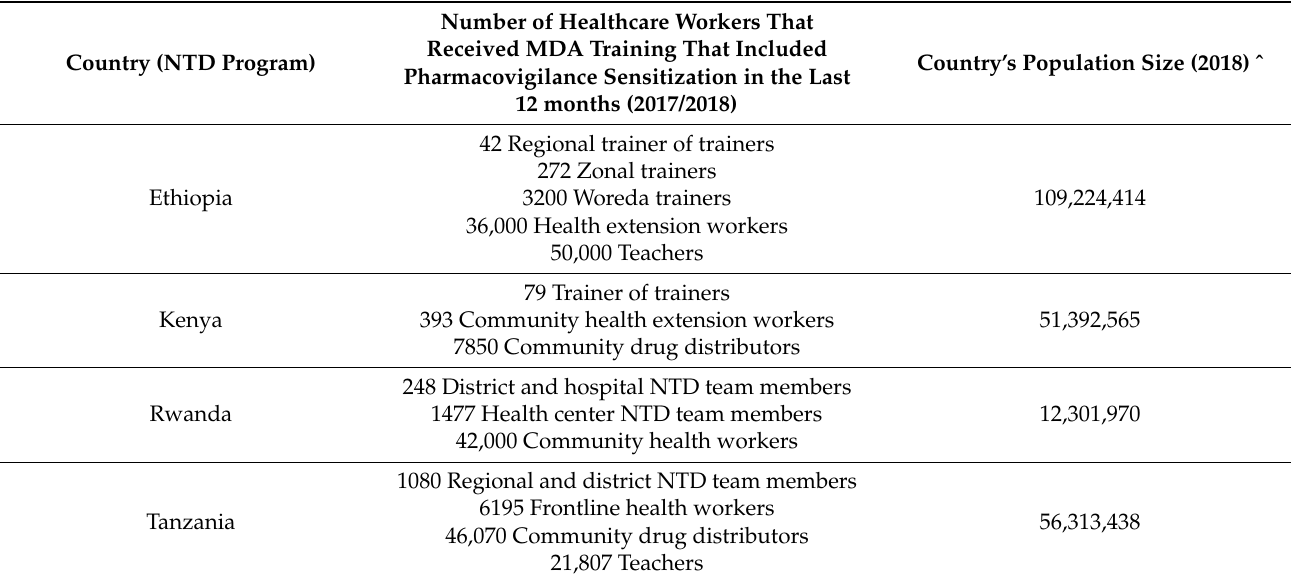
Figure 1. Pre-MDA cascade training model by country NTD program. ToT, training of trainers. Table 2. The number of healthcare workers trained in pre-MDA training in the last 12 months (2017/2018) per country NTD